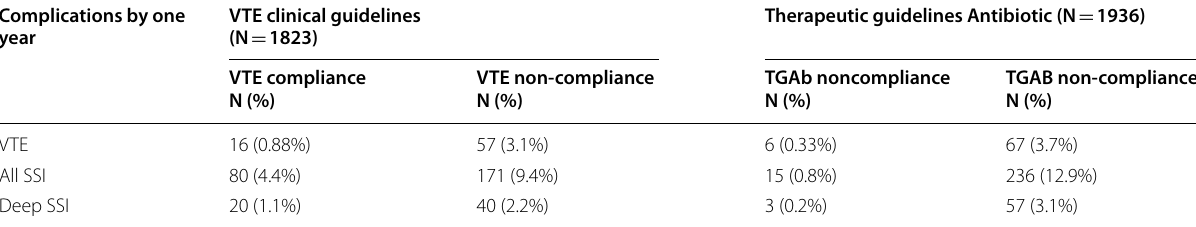
Table 5 VTE and SSI complications by VTE and antibiotic compliance and non‑compliance Complications by one